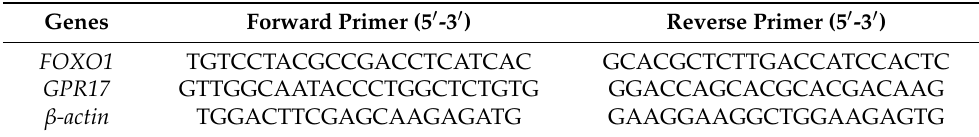
Table 1. Primer sequences of human FOXO1 , GPR17 , and β -actin genes.